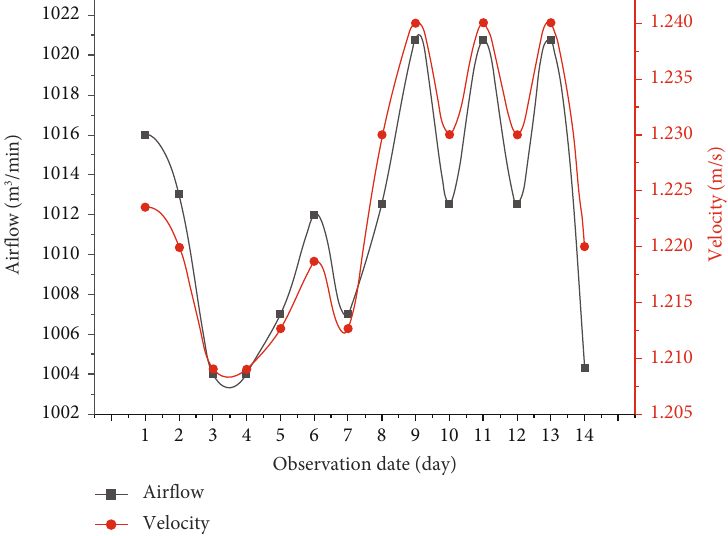
Figure 13: Wind speed and air volume monitoring results along the empty roadway.